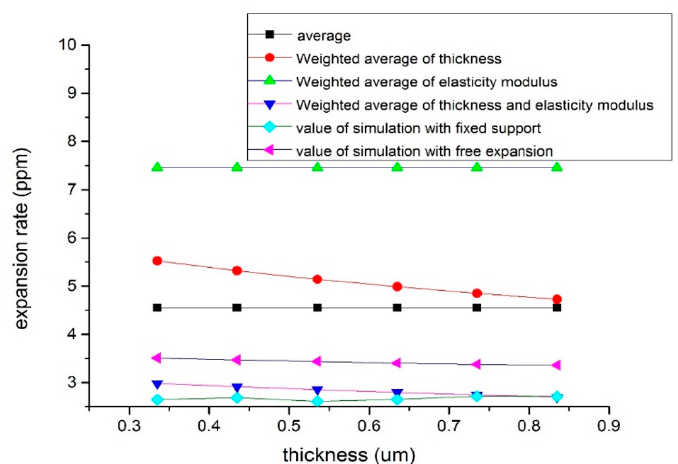
Figure 5. Stress distribution of the model during free expansion: ( a ) stress distribution at the bottom; ( b ) stress distribution on the sidewall.